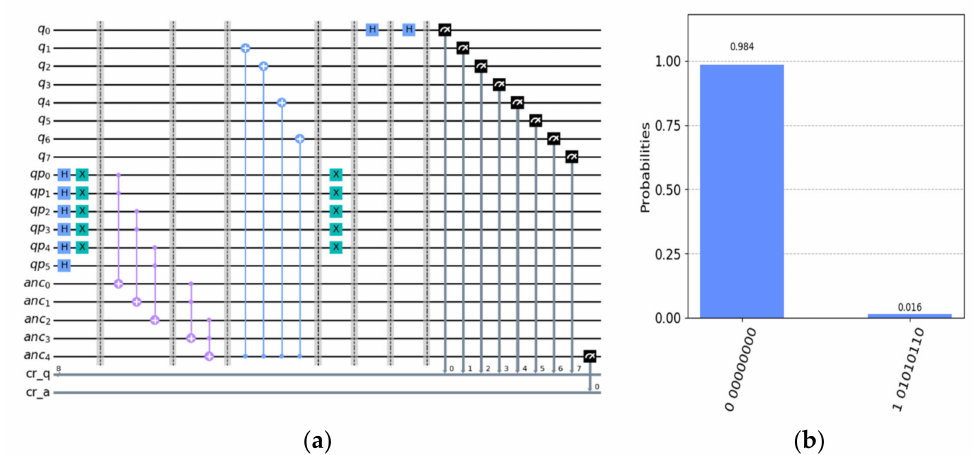
Figure 8. ( a ) The NEQR representation for the fifth pixel (gray level 86, LSB set to 0) and ( b ) the measurement results.